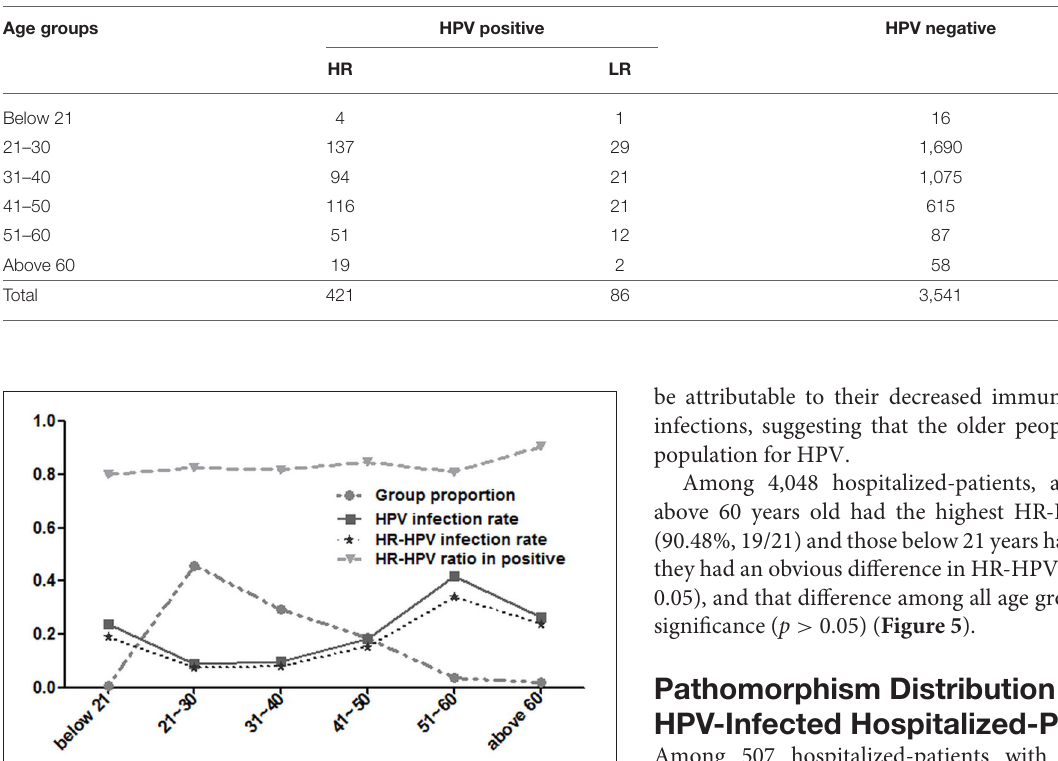
FIGURE 5 | HPV prevalence of different age groups among 4,048